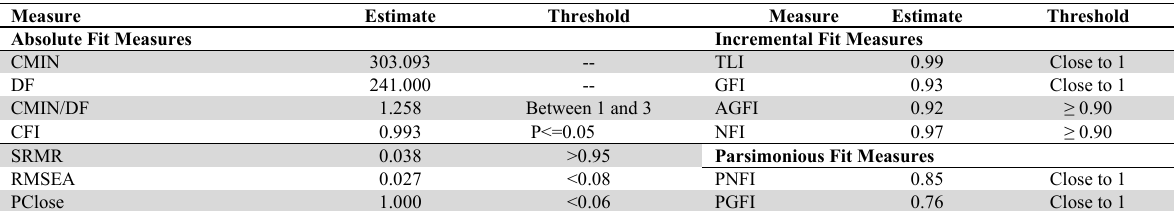
The results of HTMT HTMT Analysis Validity Analysis